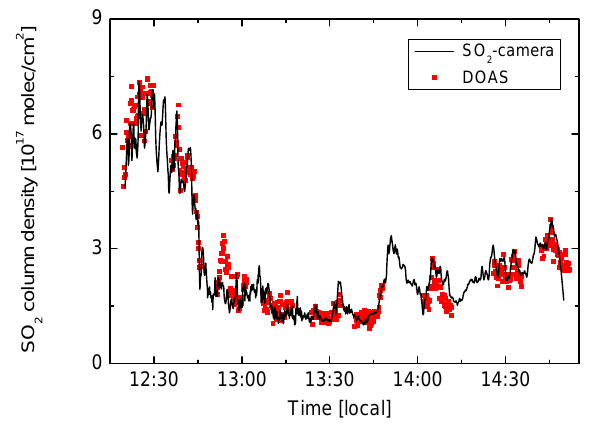
Fig. 14. SO 2 column densities measured with the passive DOAS instrument compared to those obtained in a small subsector of the SO 2 camera’s field of view (after calibration with the DOAS). The time series of the subsector with the best correlation to the DOAS data is shown.